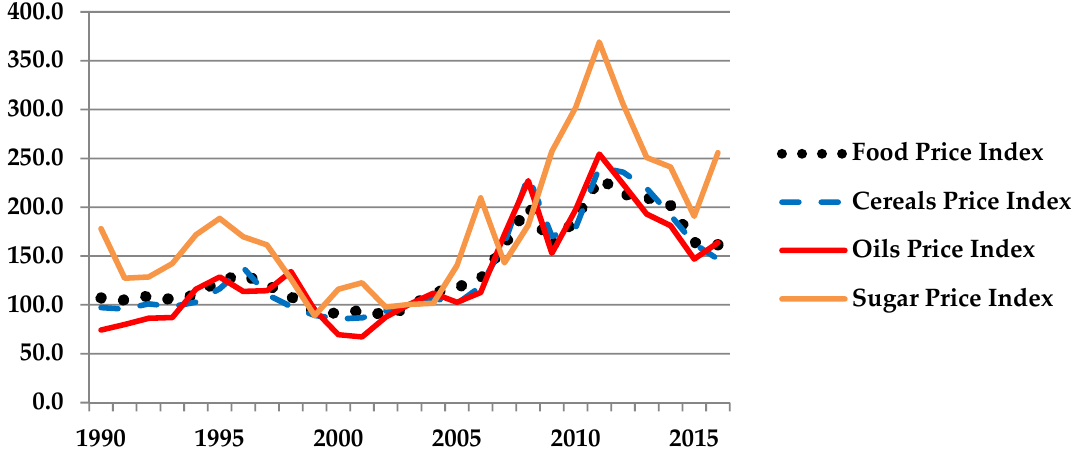
Figure 4. Food price index and key constituents. Data adapted from FAO [47]. The Food Price Index reflects the average of five commodity group price indices (cereals, vegetable oil, sugar, meat, and dairy) weighted per the average export fractions of each of the groups for 2002–2004.